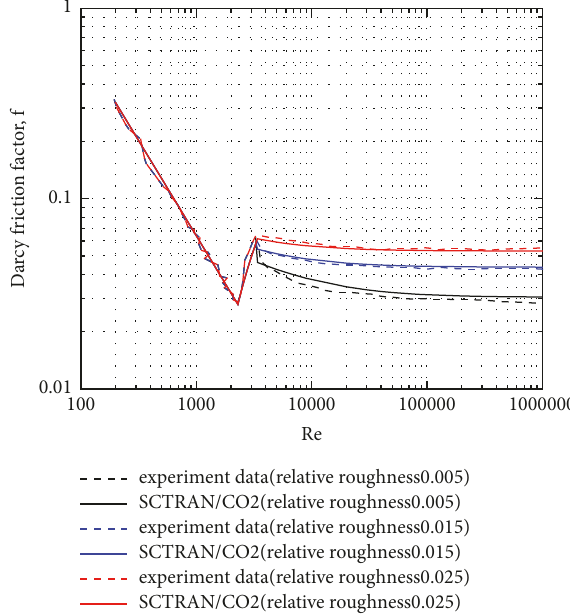
Figure 4: Comparison for friction coefficient of various roughness between experimental data and SCTRAN/CO2